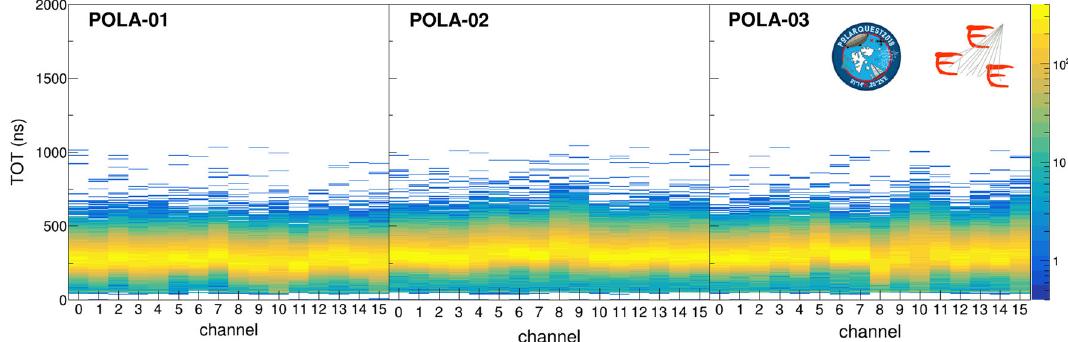
Fig. 6 TOT distributions for POLA-01, POLA-02 and POLA-03. All plots refer to data taken on July 27, 2018. The channel numbering scheme is explained in the